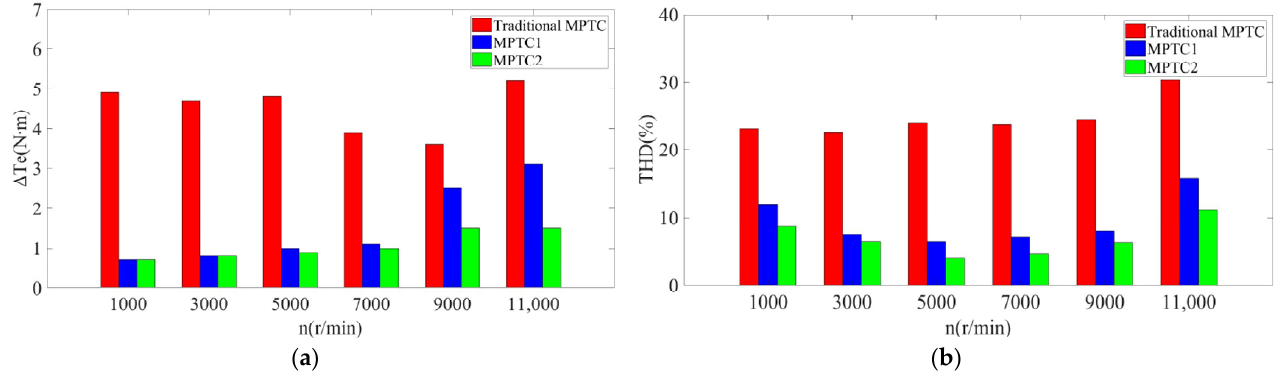
Figure 19. Performance comparisons under the load of 1.1 N·m in the full speed range: ( a ) quantitative comparisons of torque ripple; ( b ) THD comparisons.